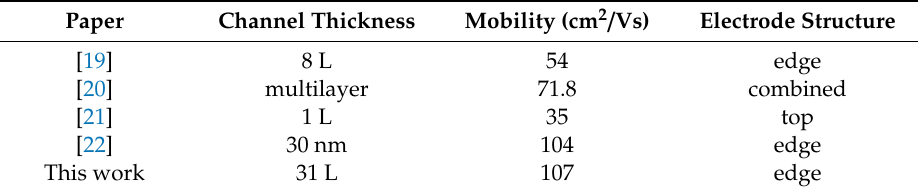
Table 1. Mobility comparison of di ff erent electrode